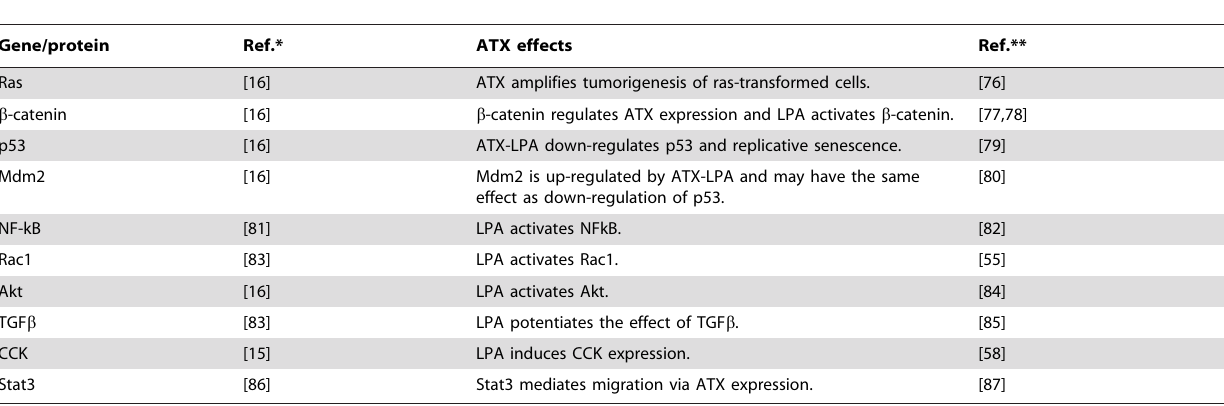
Table 5. Literature data on effects of the ATX-LPA axis on genes/proteins that have been implicated in exocrine pancreatic tumor